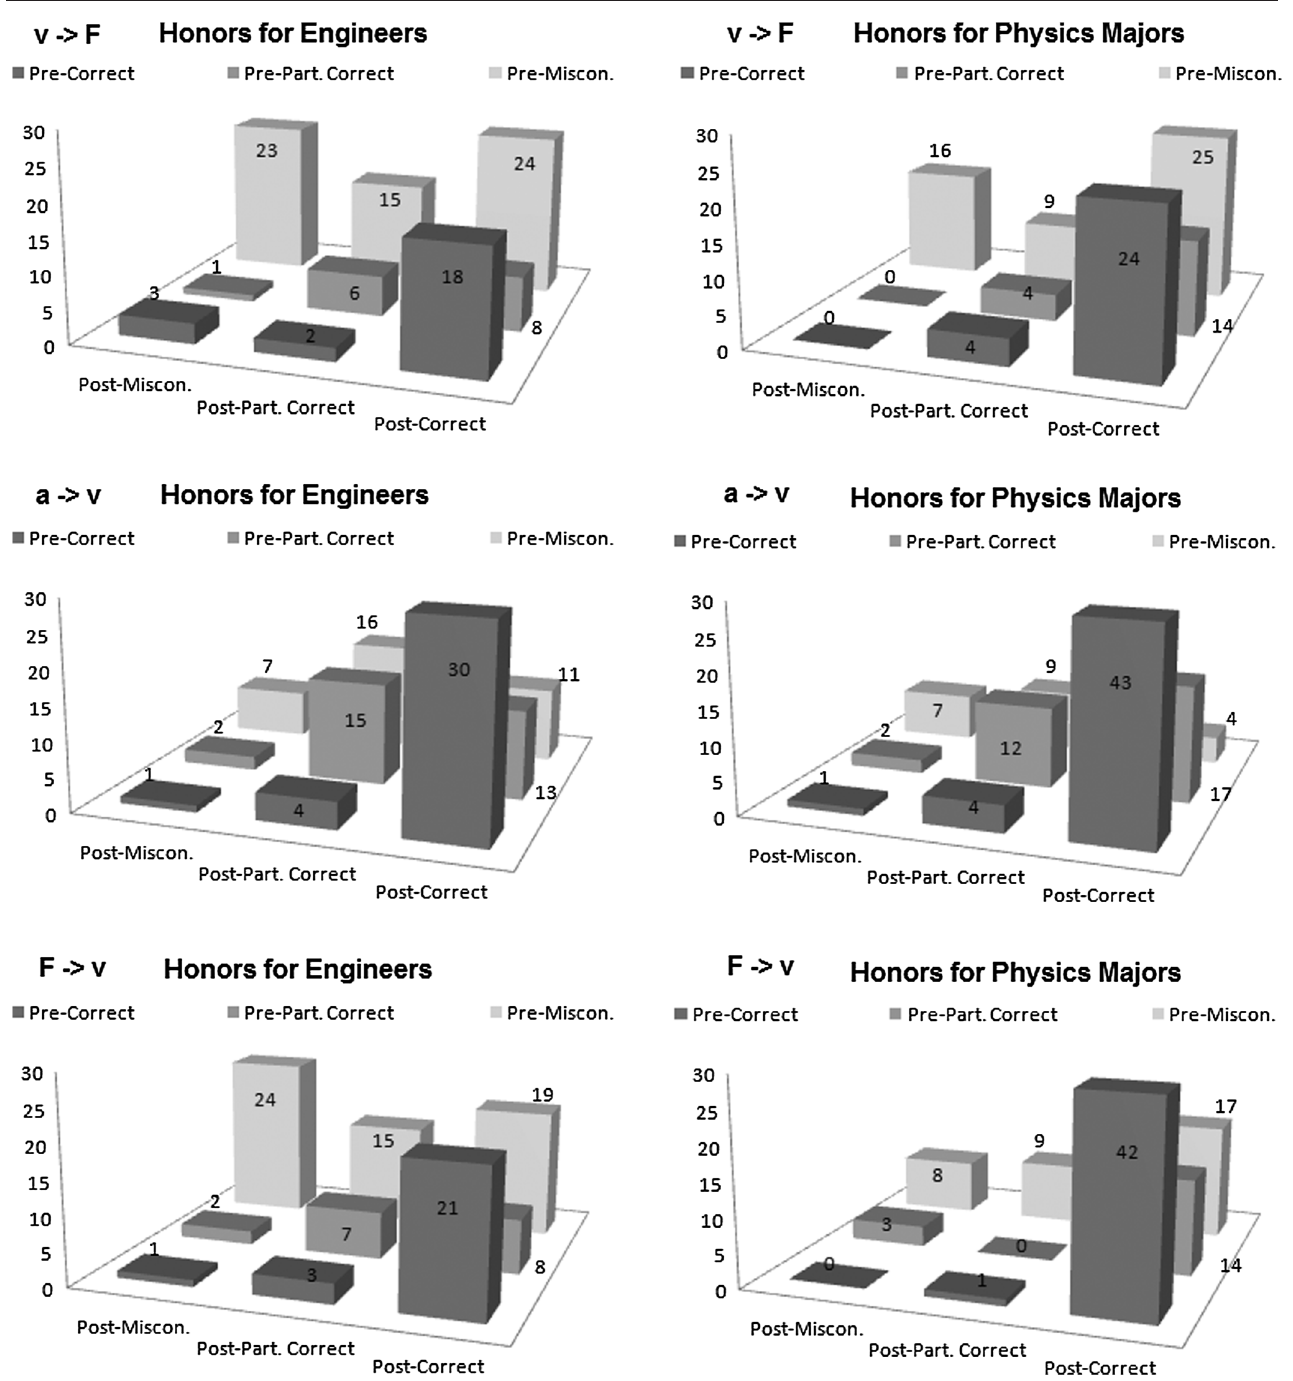
FIG. 4. Within-student, pretest versus post-test response choice percentages for the three lowest scoring question types. Responses were categorized as either Correct, Part. Correct (partially correct response), or Miscon. (misconceptionlike response). The data presented are from the honors Calculus Mechanics course for engineers, N ¼ 230 , and the first-year honors physics majors Calculus Mechanics course, N ¼ 49 . Note that roughly half of the students did not change their answer from pre- to post-test—these students are represented in the three diagonal columns from back left to front right of each graph. Also, note that a little less than half of students improved by moving into or out of a partially correct response, or directly from the misconception response to the fully correct response—these students are represented in the three columns behind and to the right of the diagonal columns—and roughly 10% of students answered less correctly from pre- to post-test—represented in the three columns to the front and left of the diagonal. (A few ~F examples from the honors for engineers ~v ! plot: 23% of students responded with a misconception on the pretest and a misconception on the post-test. 15% of students responded with a misconception on the pretest and a Part. Correct, partially correct response, on the post-test. 8% of students responded with a Part. Correct, partially correct response, on the pretest and a correct response on the